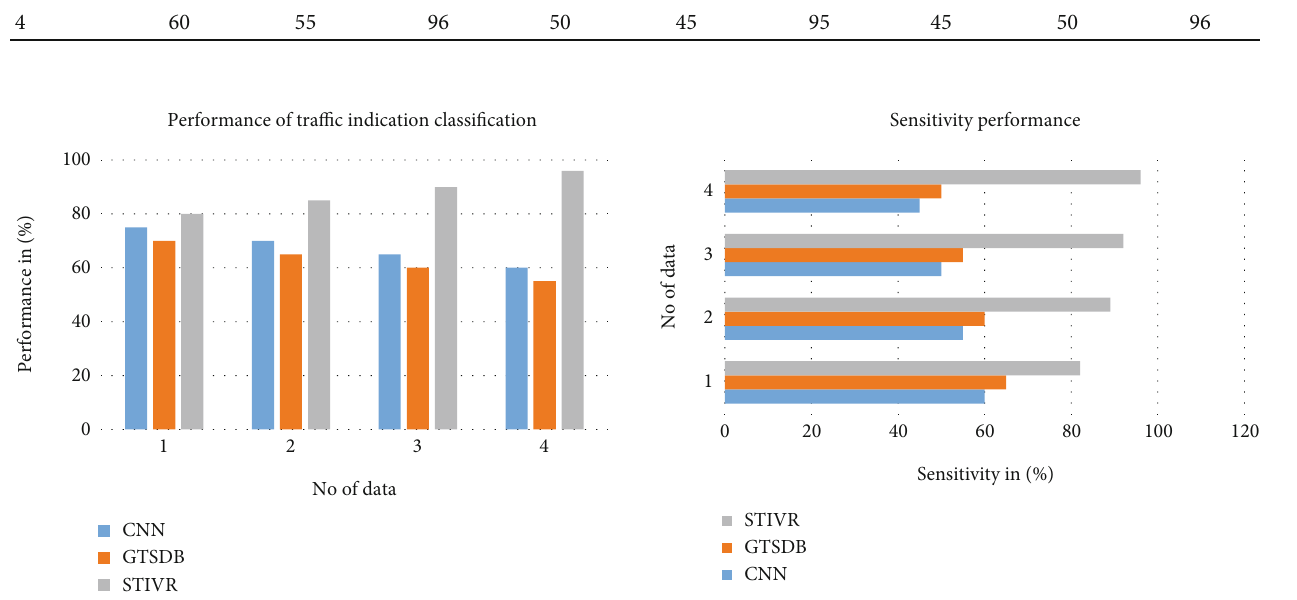
Figure 6: The evolution of the sensitivity Table 1 de fi nes the evolution of parameters in the pro- Table 2 identi fi es the performance of the STIVR based